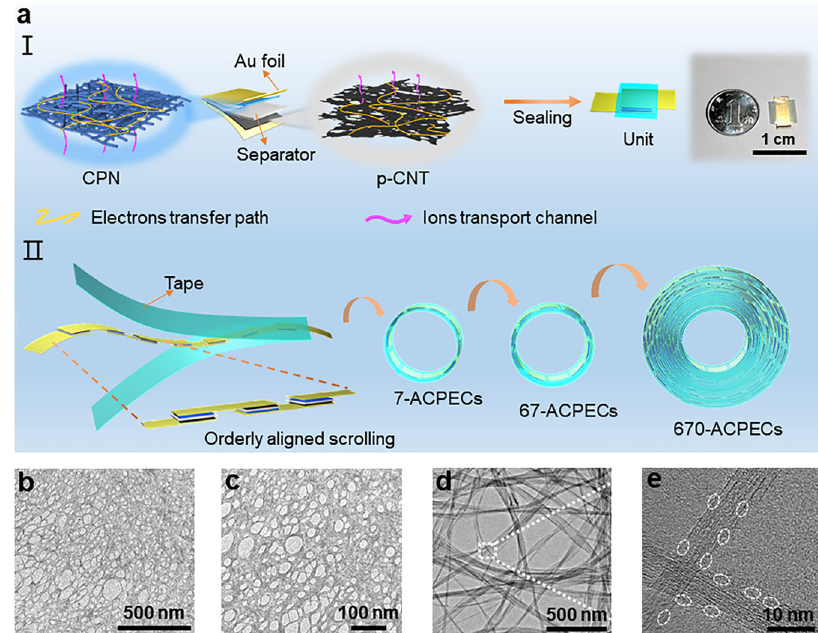
Fig. 1 | The preparation strategy of fi ltering capacitors with wide operating voltage ranges and the characterization of electrode materials. a Schematic of fabrication processes of a single ACPEC unit (I); and the integrated fi ltering capa- citors consist of different ACPEC units connected in series (II). b, c TEM images of